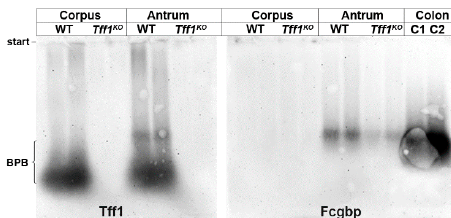
Figure 3. Western blot analyses of gastric corpus and antrum extracts of female wild-type (WT) and female Tff1 KO animals. Extracts of two animals per group were separated by 1% agarose gel electrophoresis. Shown are the reactivities for Tff1 and Fcgbp, respectively. As a positive control for Fcgbp, two murine colon extracts were analyzed (C1, C2). The start and the dye bromophenol blue (BPB) are marked on the left.